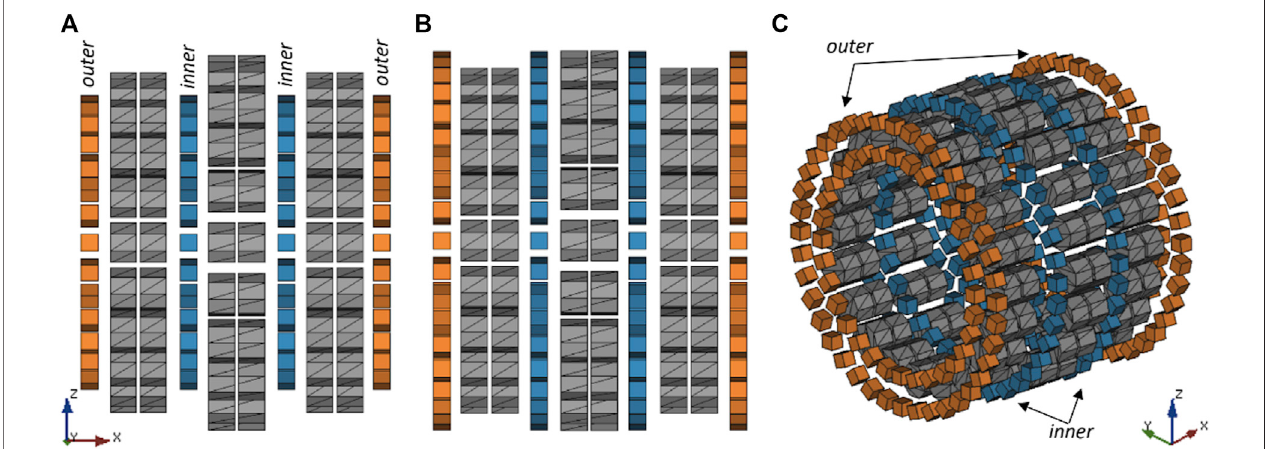
FIGURE4| Illustration oftheshimringpositionswithrespecttothebasemagnet (A) Sideviewoftheshimringpositionswithrespecttothebasemagnetrings1 – 3 (grey). Smallest radius rings of the inner (blue) and outer (orange) shim rings (for 9 mm magnet size the radius is 73 mm), (B) Sideview of the shim ring positions of the larger radius (r (cid:1) 95 mm) for the inner and outer shim rings. (C) 3D view of the fully assembled magnet and position of the stacked shim rings with respect to the base magnet.